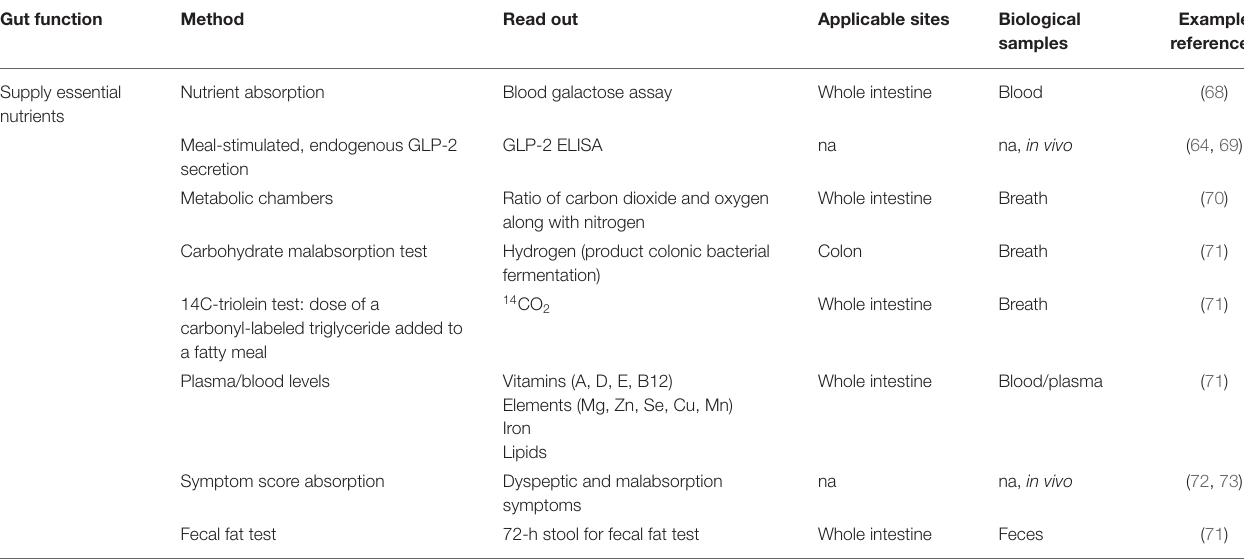
TABLE 3 | Methods described in literature to measure the supply of essential nutrients. Gut